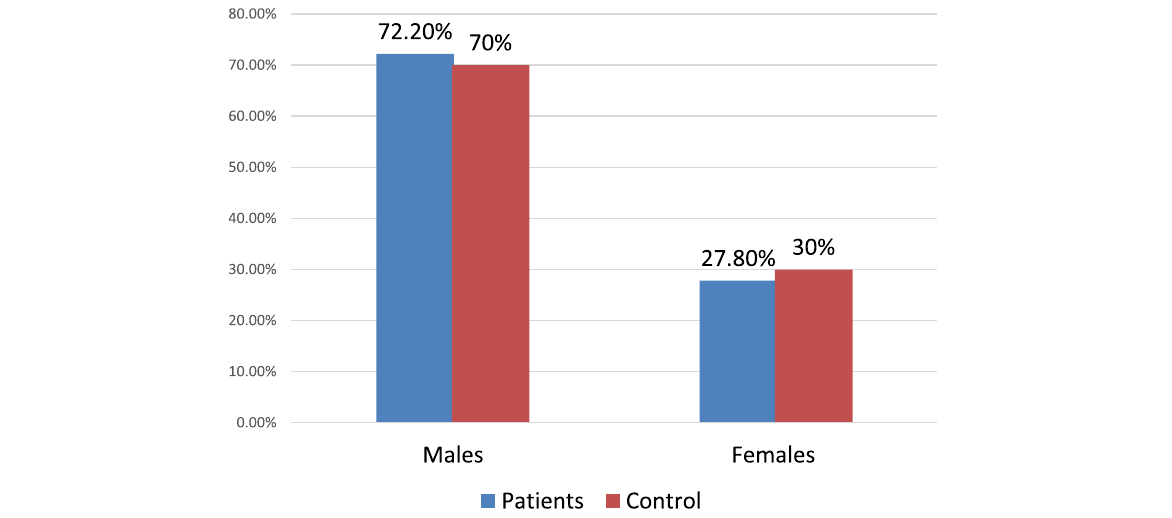
Fig. 1 Characteristic of studied groups (patients in blue and control in red) according to the age and